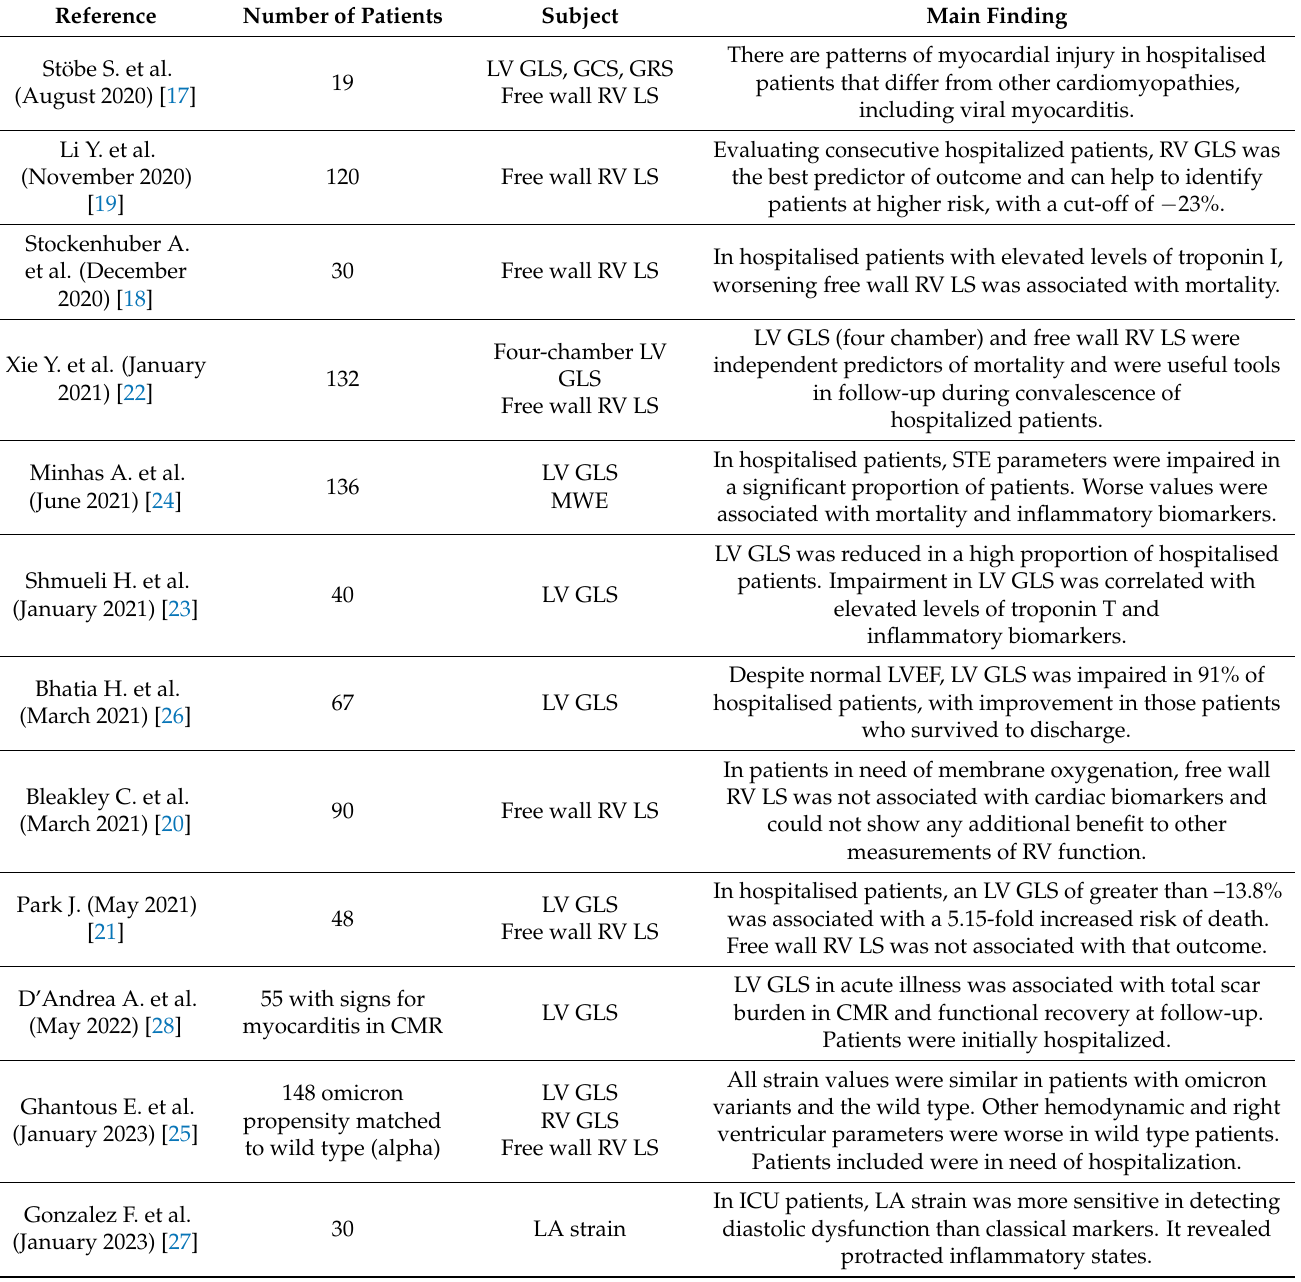
Table 1. Studies using speckle-tracking echocardiography with a focus on acute